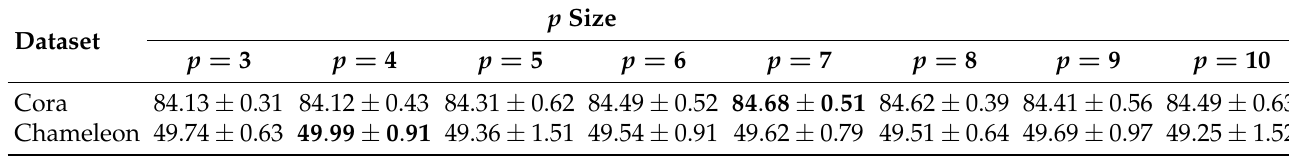
Table A3. Node classification mean accuracy ( % ) ± stdev for different p